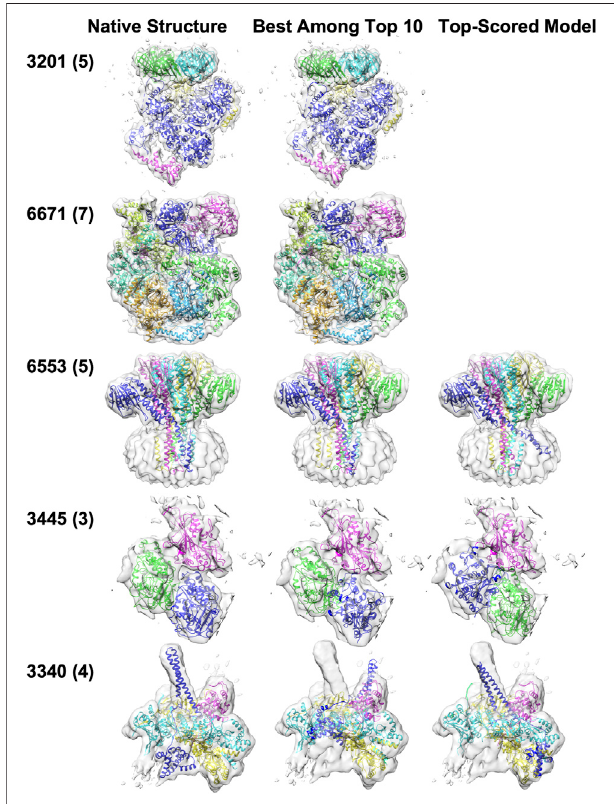
FIGURE 6 | Structure fi tting examples of experimental map targets. The number of chains in a complex is shown in the parentheses. The middle panel shows the best among the top 10-scored models, and the right panel shows the top-scored models. Only one fi tted structure was shown for EMD- 3201 and EMD-6671because the top scored model was the best among top 10-scored models. (EMD-3201, PDB ID: 5FKU), the E. coli replicative